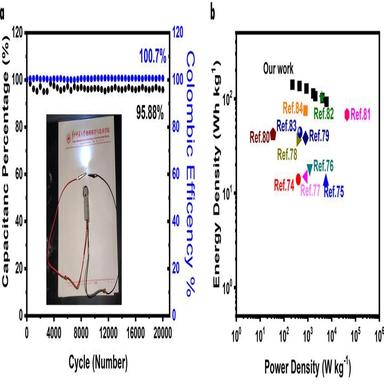
Illustrates (a) The cycling performance of the Ni-NSAs@Ni foam//AC HSC device, inset is a photograph of white light-emitting-diode (LED) powered by the as assembled Ni-NSAs@Ni foam//AC devices, (b) Ragone plot between energy and power densities and some other related works.